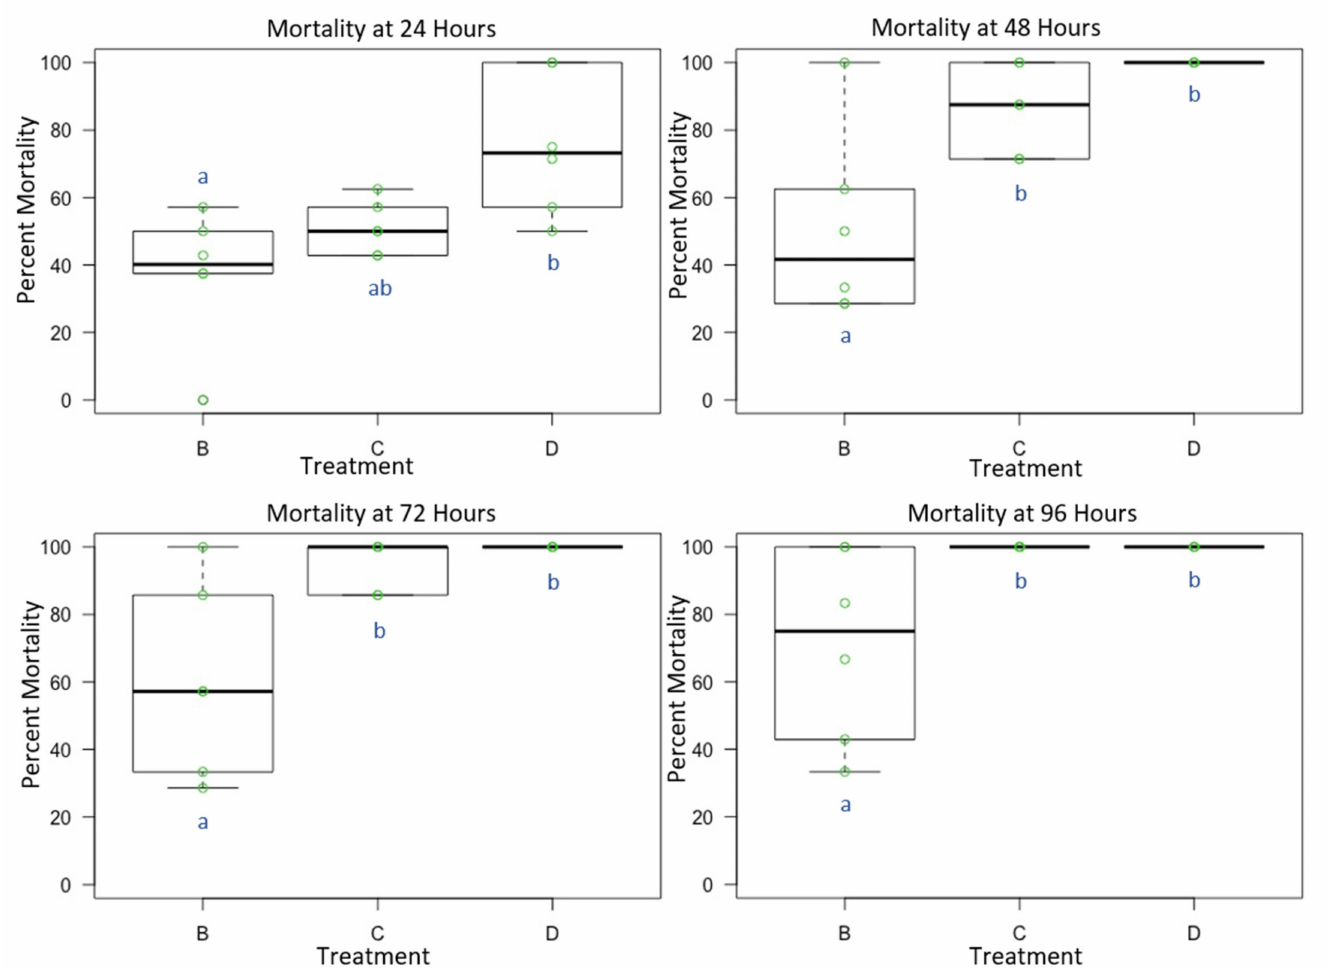
Figure 4. Female Osmia lignaria Acute Contact Toxicity Following Whole-Body Contact Exposure to Individual Active Ingredient Insecticides and their 1:1 Binary Combination: Female Osmia lignaria mean, 1st and 3rd quartile percent mortality following whole-body contact exposure to each individual active ingredient insecticide (Experiment 3) at 24 and 48 h. Data on the x-axis indicate each insecticide treatment, and data on the y-axis indicate percent mortality. Insecticide treatments: B = I, C = BC, D = IBC. All jars in a treatment containing the respective percent mortality are represented by a single green point. Significant difference at p < 0.05 (pairwise comparison) is indicated by different letters (a, b). Information related to control is given in the result